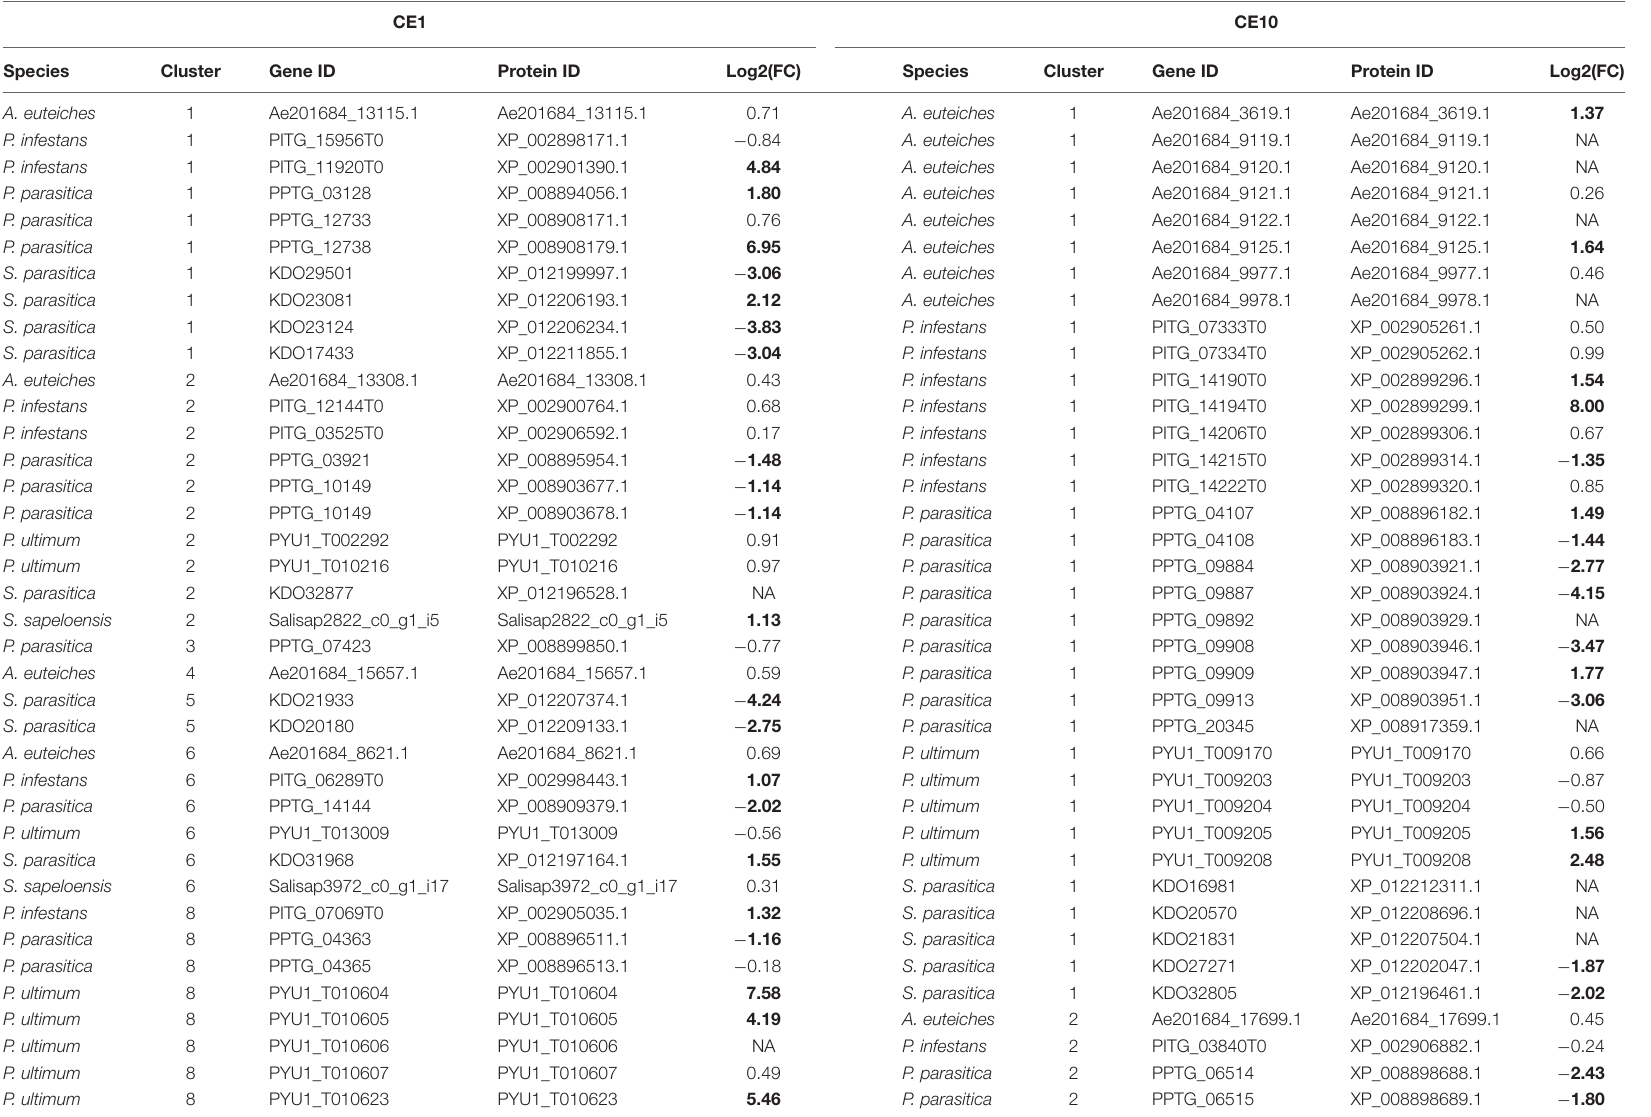
TABLE 1 | Differential gene expression changes for carbohydrate esterase 1 (CE1)- and 10 (CE10)-encoding genes calculated as log 2 [fold change (FC)] for growth during infection/colonization vs. growth on medium. CE1 CE10